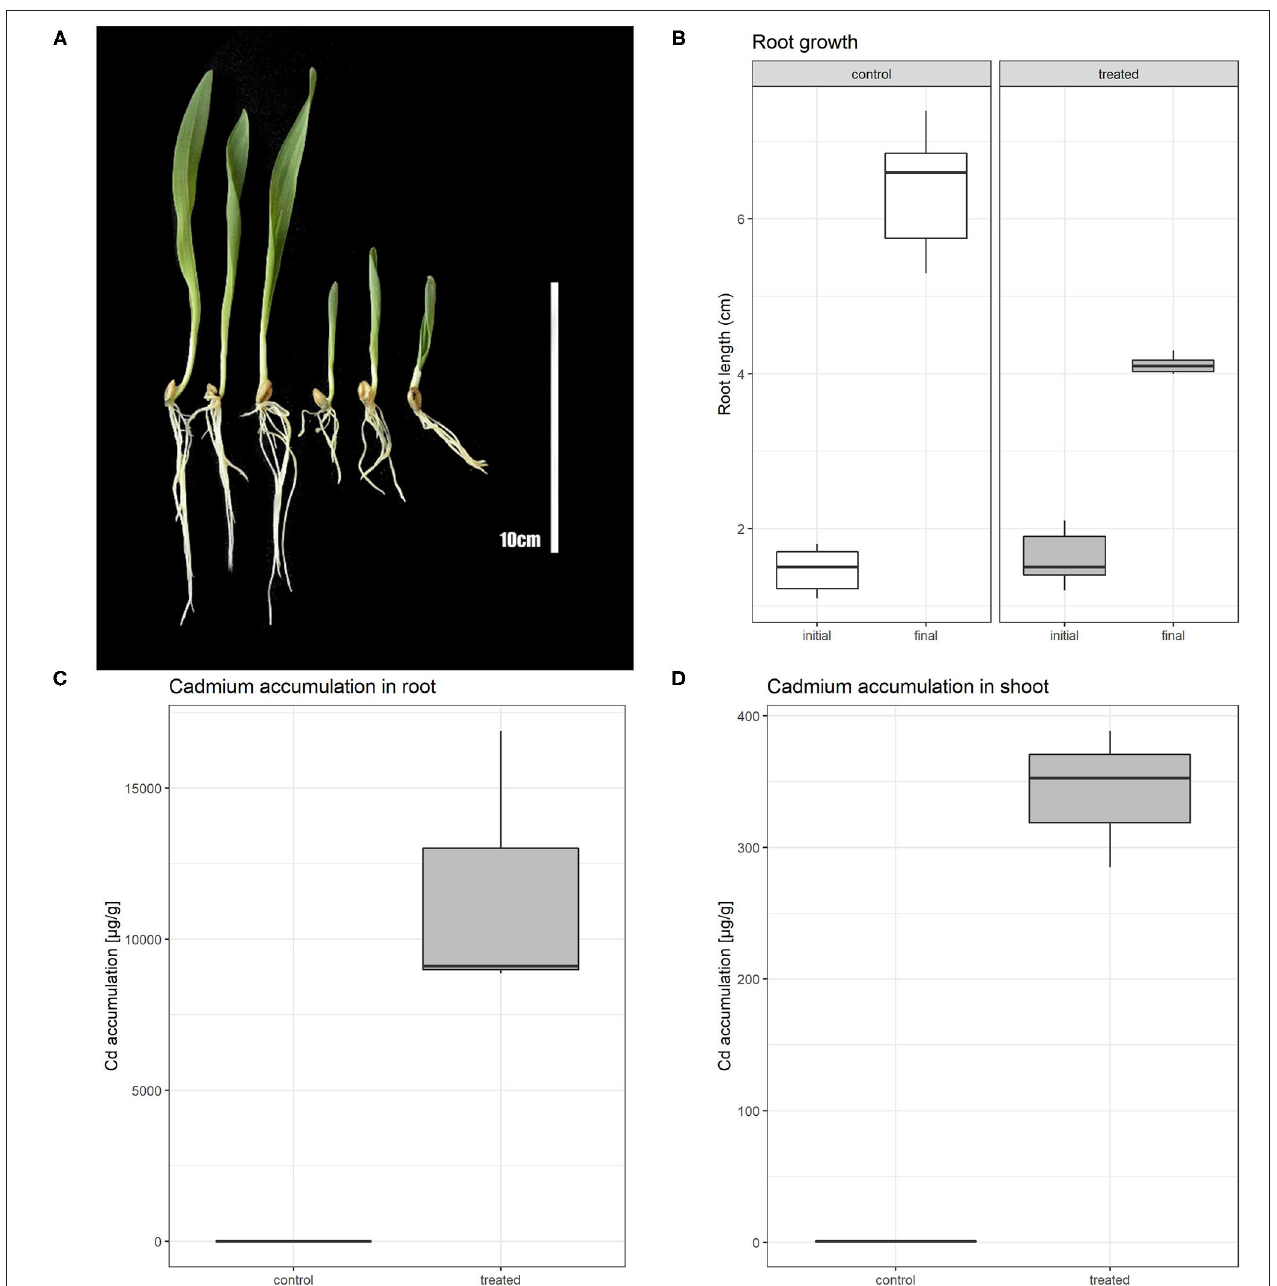
FIGURE 1 | Phenotypic comparison of control and Cd treated plants (A) ; left section represents control plants, right section Cd treated plants. Boxplot showing root length of barley plants at the beginning of experiment (initial) and after 5 days of Cd or control treatment (final) (B) . Boxplot of cadmium accumulation for both control and treated plants in root (C) and shoot (D)